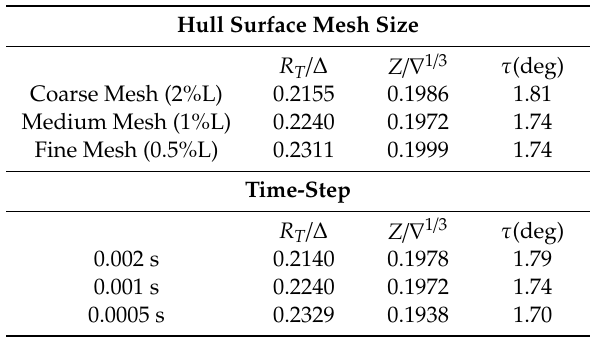
Table 7. Mesh and time-step sensitivity